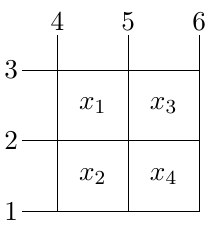
Figure 7 . The web diagram for Gr(3 ;